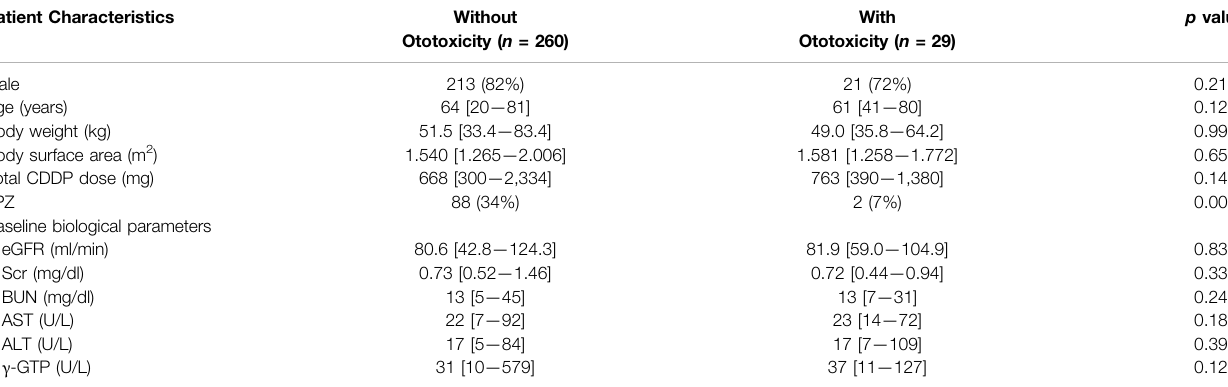
TABLE 2 | Comparison of characteristics between CDDP-treated patients with ototoxicity and without ototoxicity in EHR of Mie University Hospital. Patient